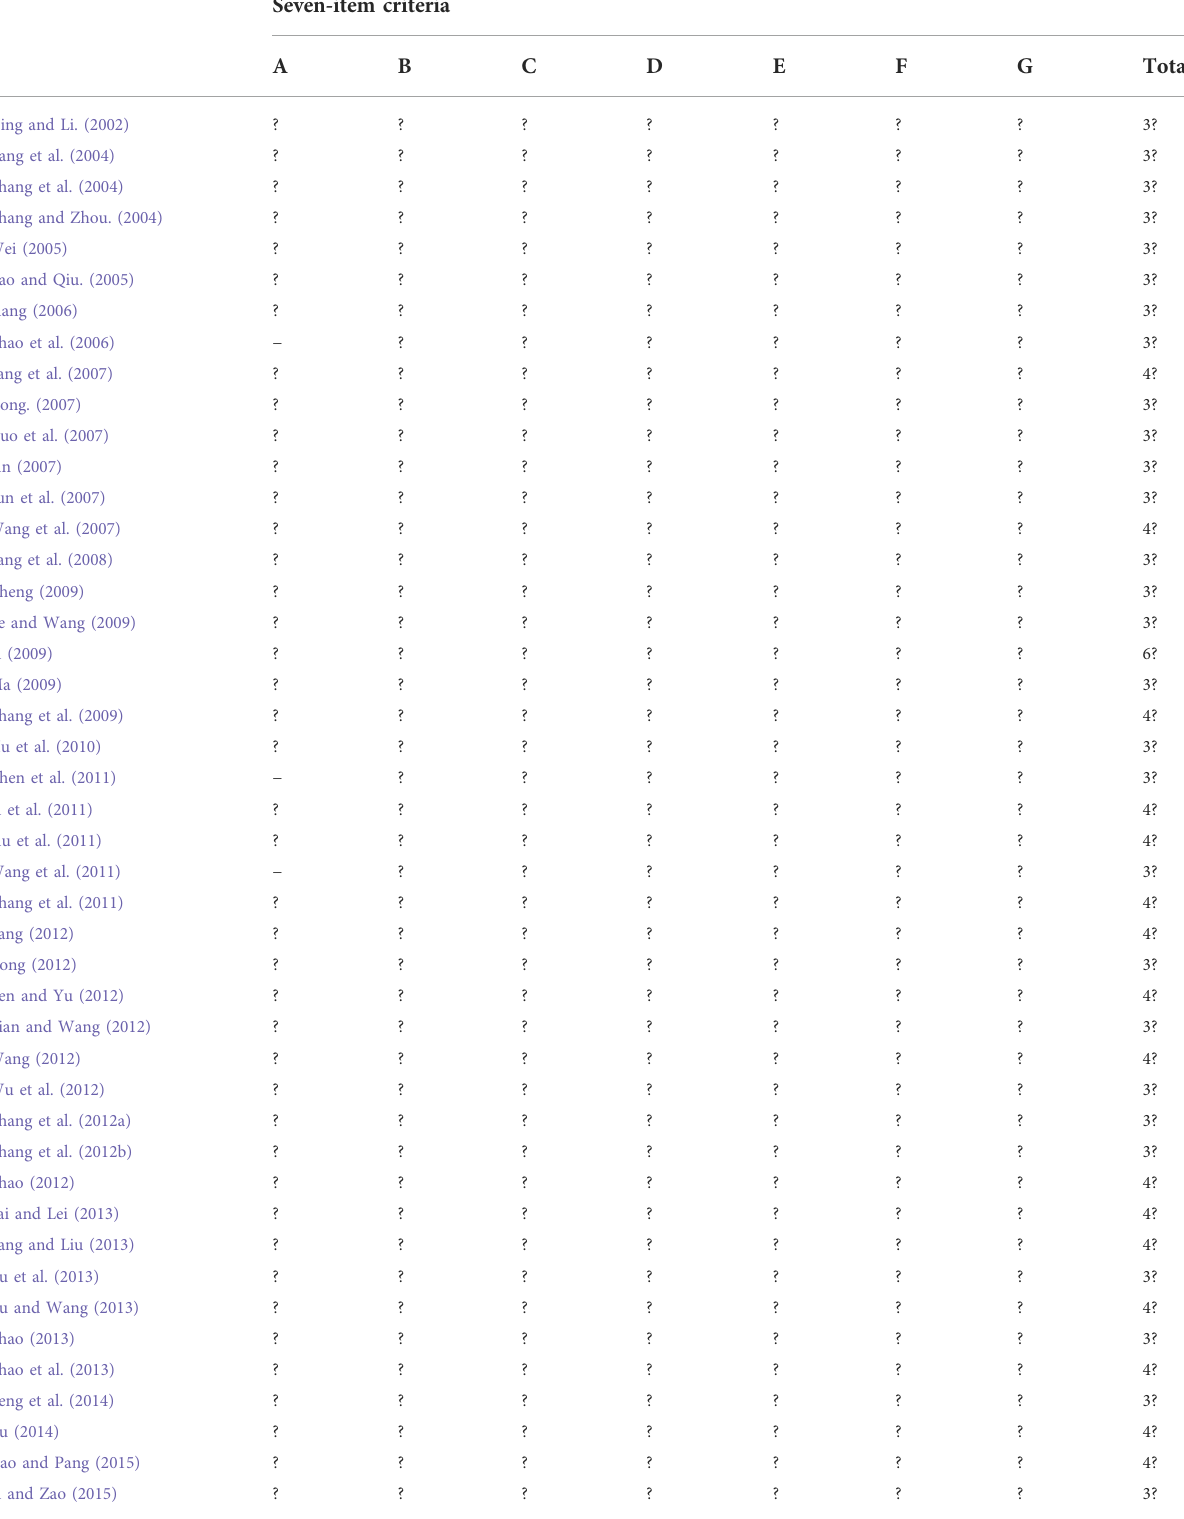
TABLE 3 Risk of bias assessment of all included studies.